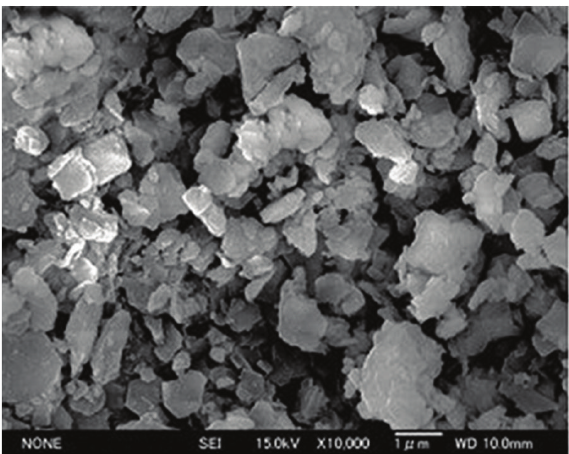
Figure 2: Microstructure of blast furnace slag through field emis- sion scanning electron microscope (FESEM) showing particle size distribution [36].